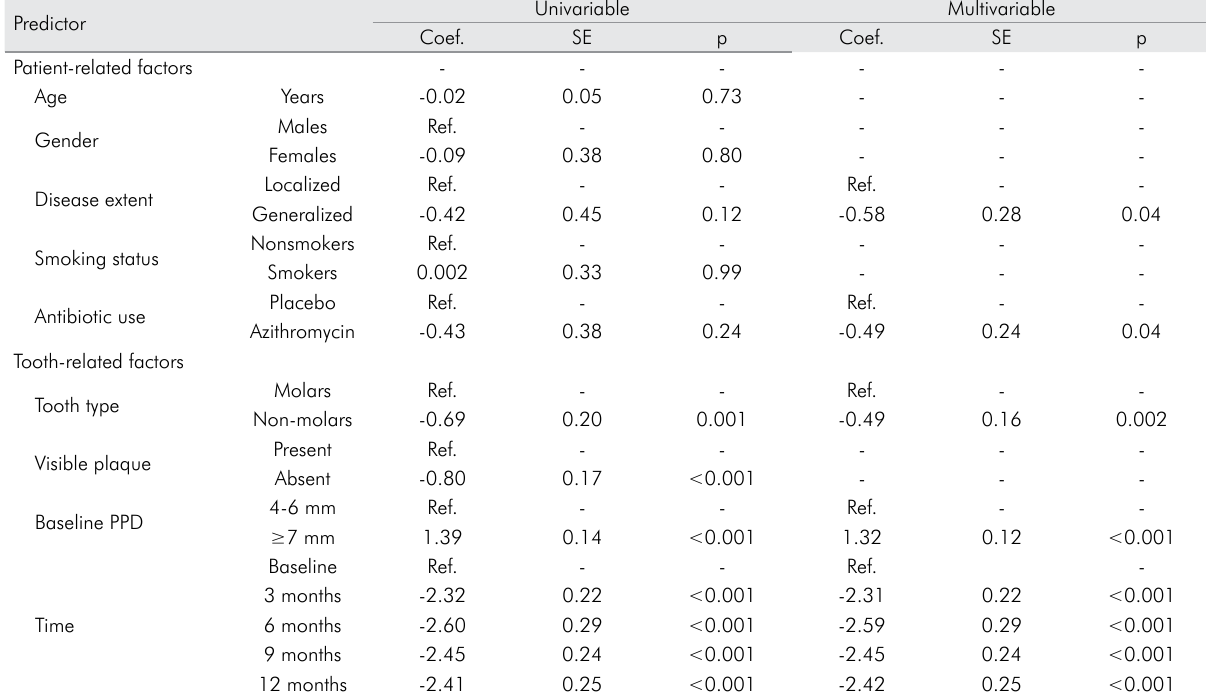
Table 2. Univariable and multivariable prediction models of PPD change over 12 months Predictor